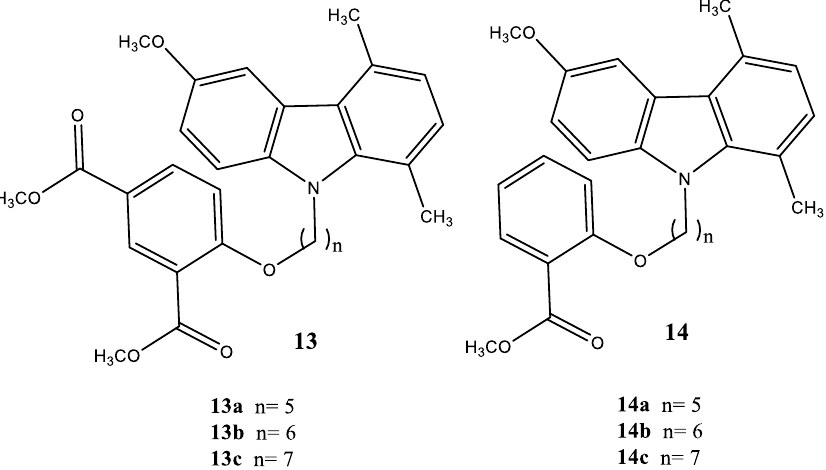
Figure 9. Structure of: hydroxyisophthalate derivatives ( 13 ) and methyl salicylate derivatives ( 14 ).